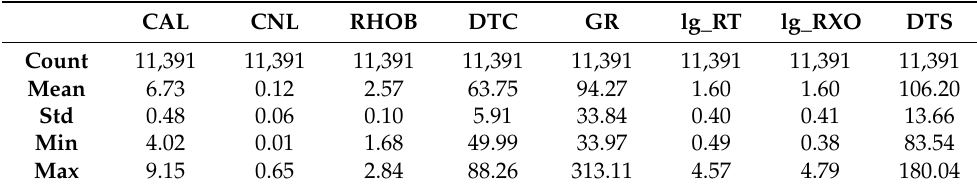
Figure 6. Detection of abnormal values (yellow for null, blue for non-null). Table 1. Statistical table after deleting abnormal values.